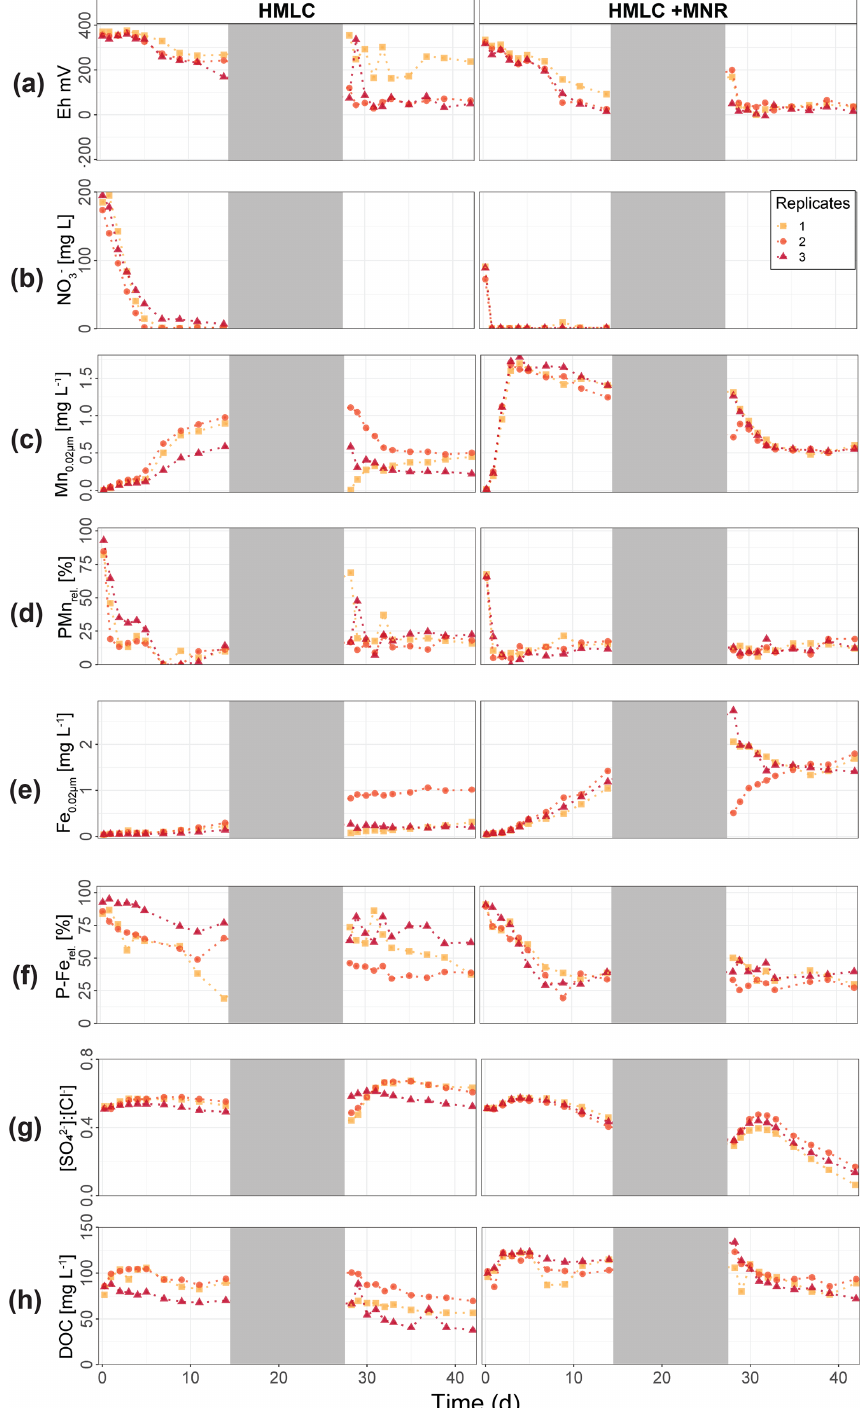
Figure 2. Soil solution dynamics in cornfield soil (HMLC) incubations for redox potential (a) , redox reactive elements (NO − Fe, P-Fe, [SO 2 − ]:[Cl − ]) (b–g) and dissolved organic carbon (h) . Lines between points were plotted to improve readability. The gray area 4 indicates the drained